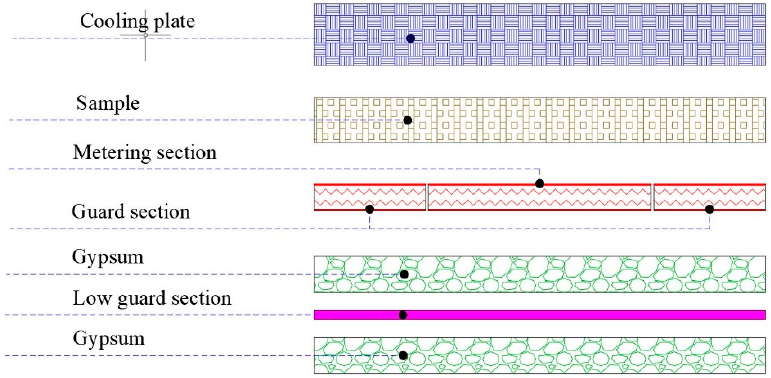
Figure 3. Section of the guarded hot plate apparatus.